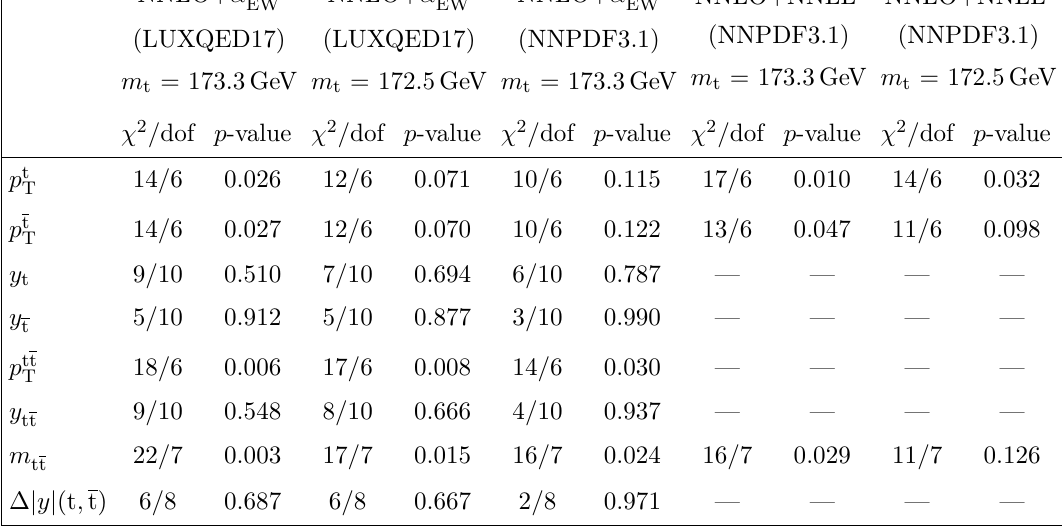
Table 52 . The (cid:31) 2 /dof and p -values quantifying the agreement between the (cid:12)ve theoretical pre- dictions with NNLO+ (cid:11) 3 and NNLO+NNLL 0 precision and the measured, parton-level absolute EW cross sections are